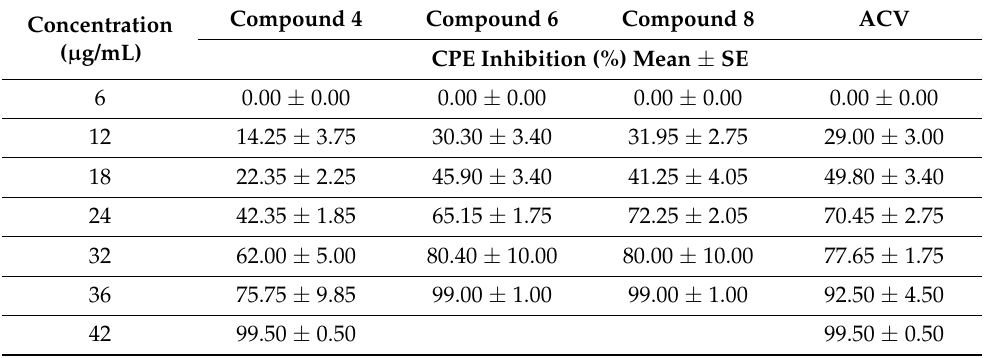
Figure 3. Inhibitory effect of tested compounds and ACV represented by average EC 50 . According to statistical analysis, it was found that compounds 4 , 6 and 8 were active against HSV-1 with an average EC 50 of 25.23, 15.76 and 15.1, respectively, which were close to that of ACV (13.96). There was also an insignificant difference ( p > 0.05) between their EC 50 values compared to that of ACV, but there was a significant difference ( p < 0.05) between them and those of other compounds. Some compounds ( 3 , 5 and 12 ) showed mod- erate activity l with an EC 50 of 36.69, 31.54 and 30.35, respectively. The other compounds ( 7 , 9 , 10 , 11 , 13 and 14 ) showed low activity. The strongest antiviral synthesized compounds were chosen, and the antiviral assay experiment was repeated three times. The results are reported in Table 2. Table 2. Inhibition of HSV-1-related CPE by using different concentrations of the most potent tested compounds and a standard drug